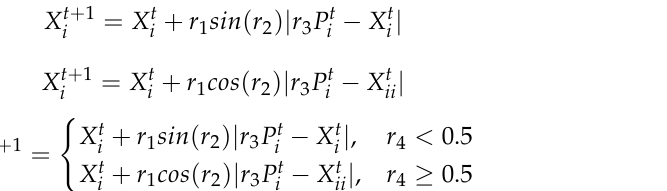
is the position of the current i